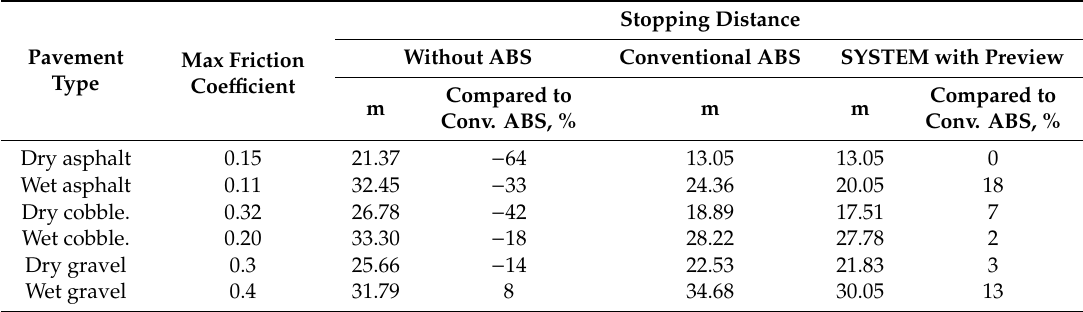
Table 5. Stopping distance.